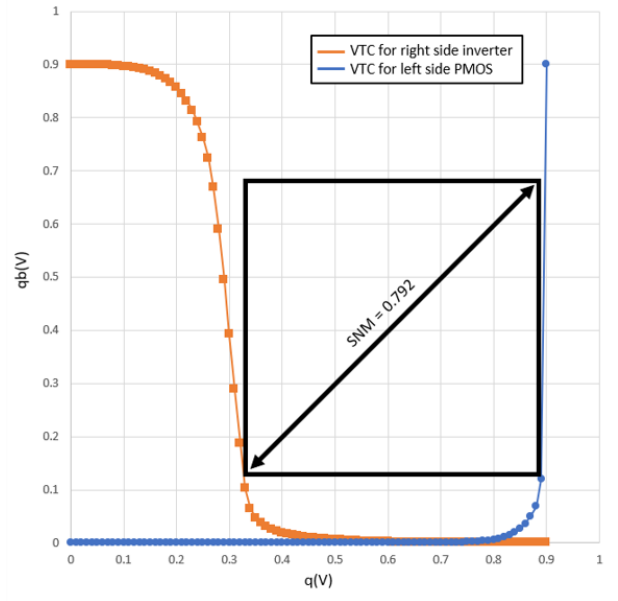
Figure 12. Hold Static Noise Margin (SNM) of the Proposed 8T SRAM bit cell.